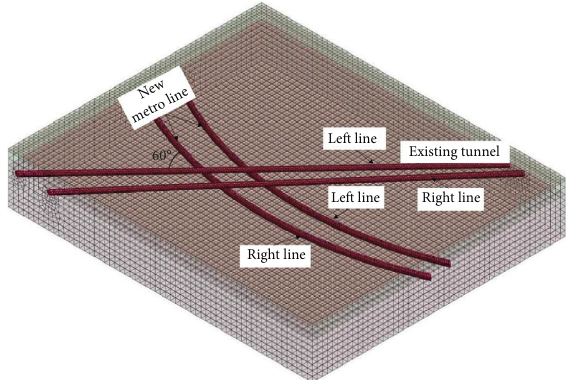
Figure 6: 3-D finite element model.